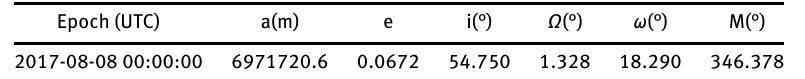
Table 5. Osculating orbital element of CZ-3B 3rd